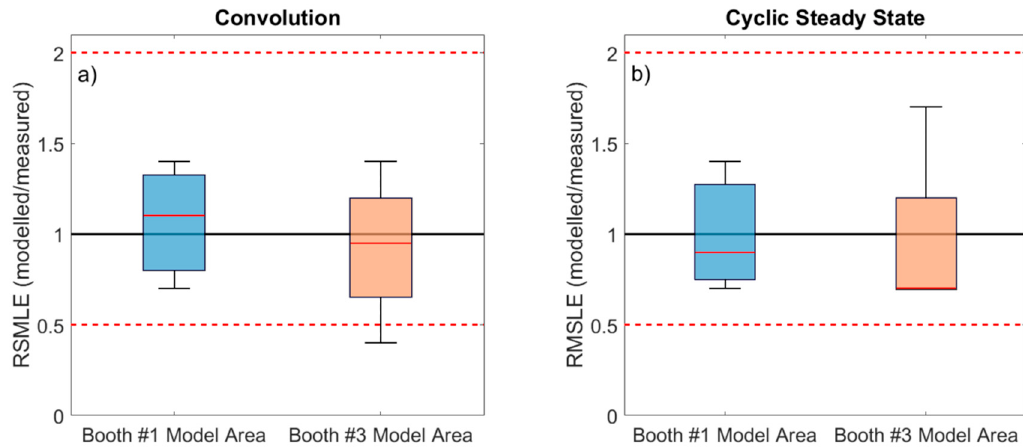
Figure 4. Vertical box plot for RMSLE modeled / measured concentrations for booth#1 and booth#3 model areas using convolution SN (a) and Cyclic steady state SN (b) . Ratio 0.5 and 2 are marked as reference (dashed line). The boundary of the box closest to zero indicates the 25th percentile and the farthest from zero the 75th percentile. The solid red line within the box indicates the median value. Error bars above and below indicate the 10th and 90th percentiles.